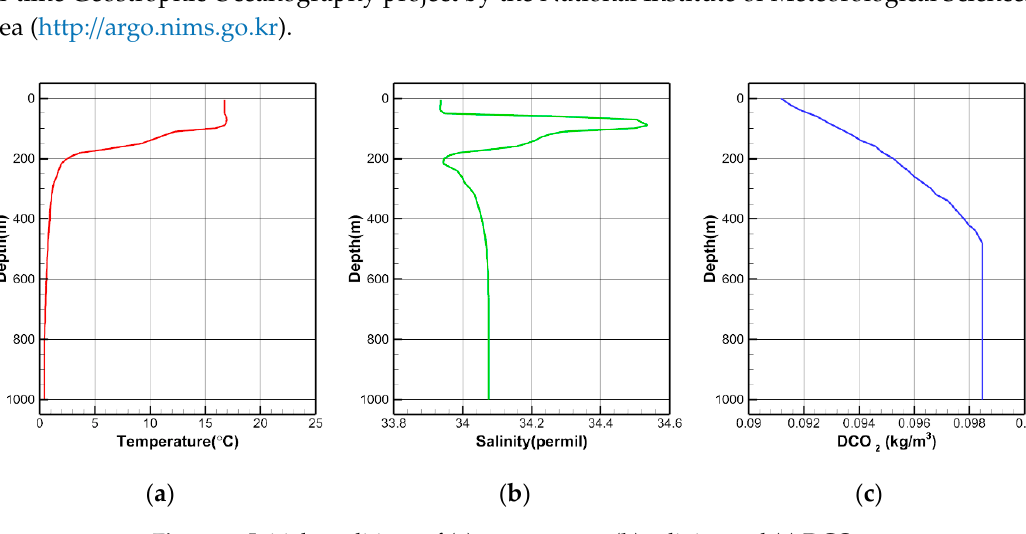
Table 2. Tidal components used for open boundary conditions.